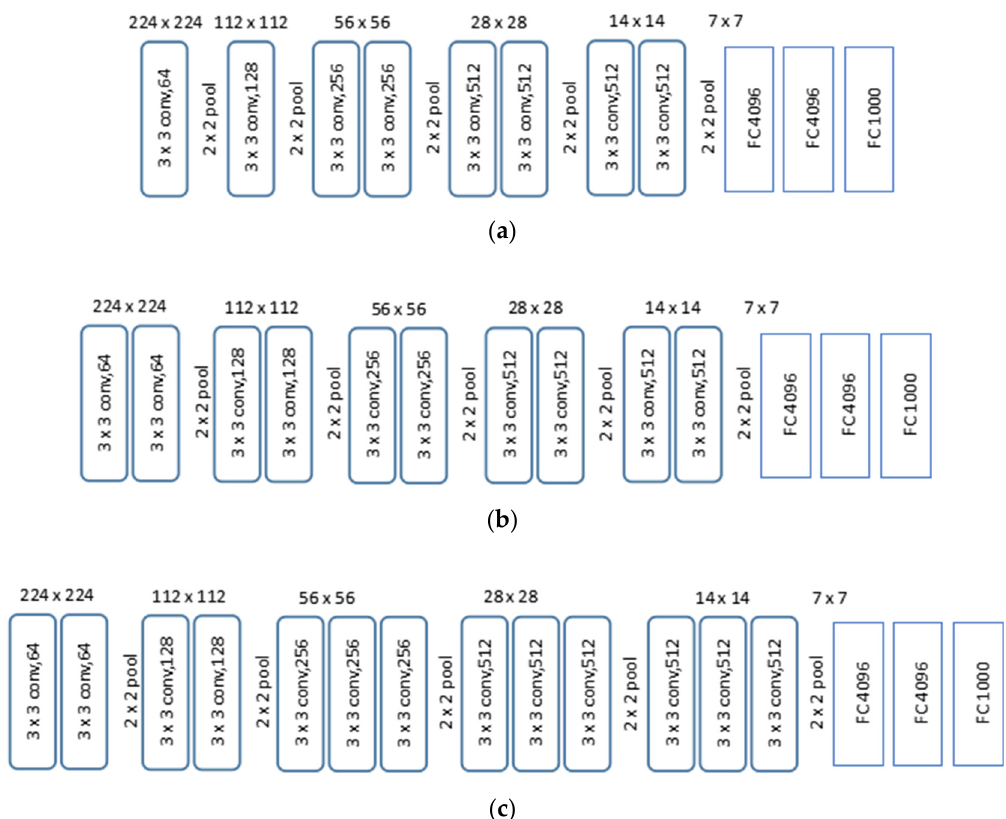
Figure 7. Structure of correlation distance extraction CNN. ( a ) Net D; ( b ) Net E; ( c ) Net F.